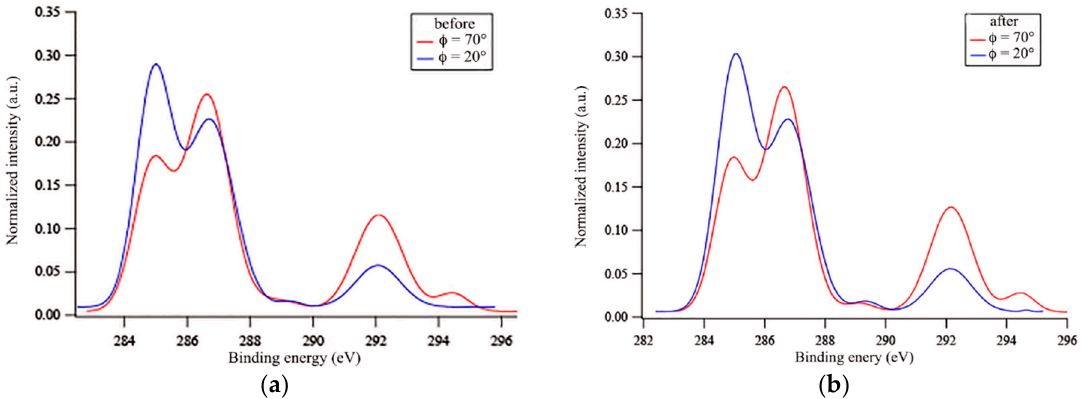
Figure 8. Area-normalized C(1s) XPS signals at φ of 70° and 20° for the film E13-S27Sz A 11_100 before ( a ) and after ( b ) 7 days of immersion in water.